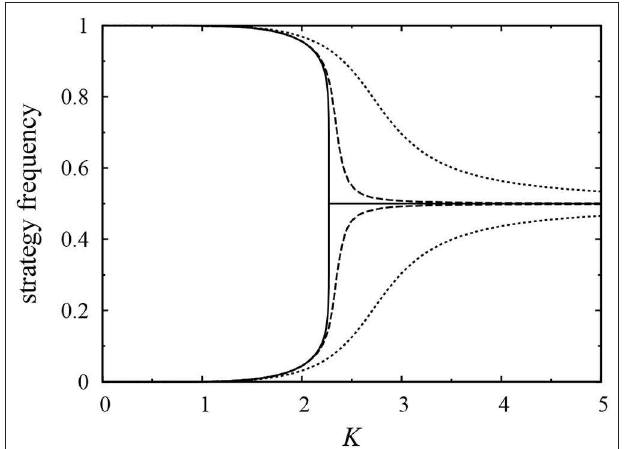
FIGURE 1 | Strategy frequencies vs. K in two-strategy potential games played on a square lattice for three different self-dependent components and ν 12 The solid lines show Onsager’s exact results [49] in the ε 1 upper (lower) dashed and dotted lines show the frequency of the favored strategy 1 (suppressed strategy 2) for ε 1